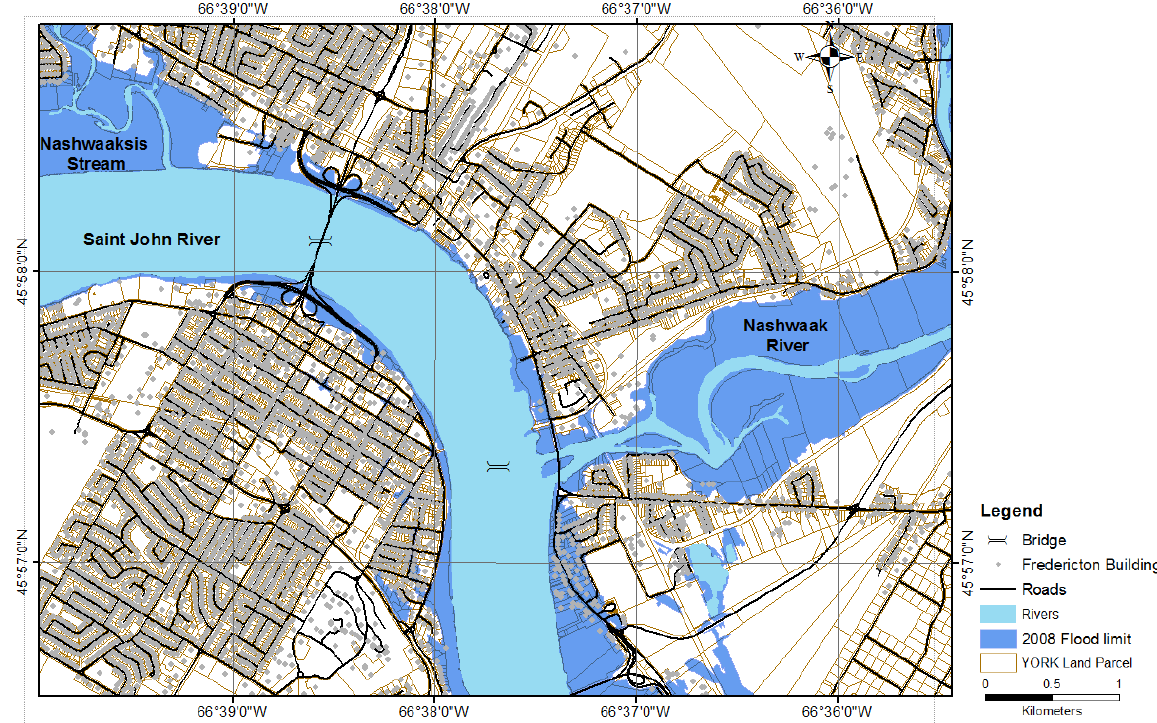
Figure 5 Buildings, essential facilities, transportation network, and 2008 flood extent in Fredericton. Source: City of Fredericton and Service New Brunswick,